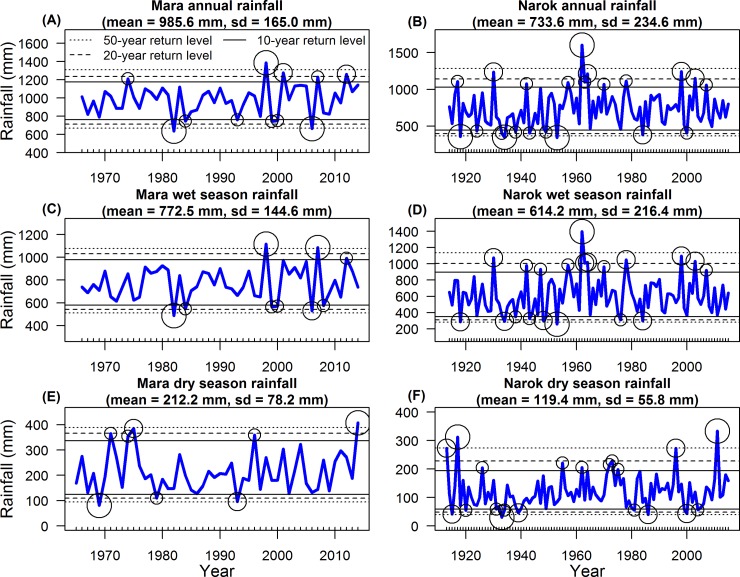
Extreme values (circles) for the annual, wet season and dry season rainfall components.The thin lines are the 50-year (dotted), 20-year (dashed) and 10-year (continuous) return levels. (A, C, E) Rainfall recordings in the Mara were derived from 15 gauges (Eq 3 in S1 Text) during 1966–2014 (dry season: 1965–2014). (B, D, F) Rainfall in Narok Town in Kenya was recorded during 1914–2015 (dry season: 1913–2015). The (A, B) annual, (C, D) wet season and (E, F) dry season rainfall components (thick blue lines) were summed from the monthly rainfall records.